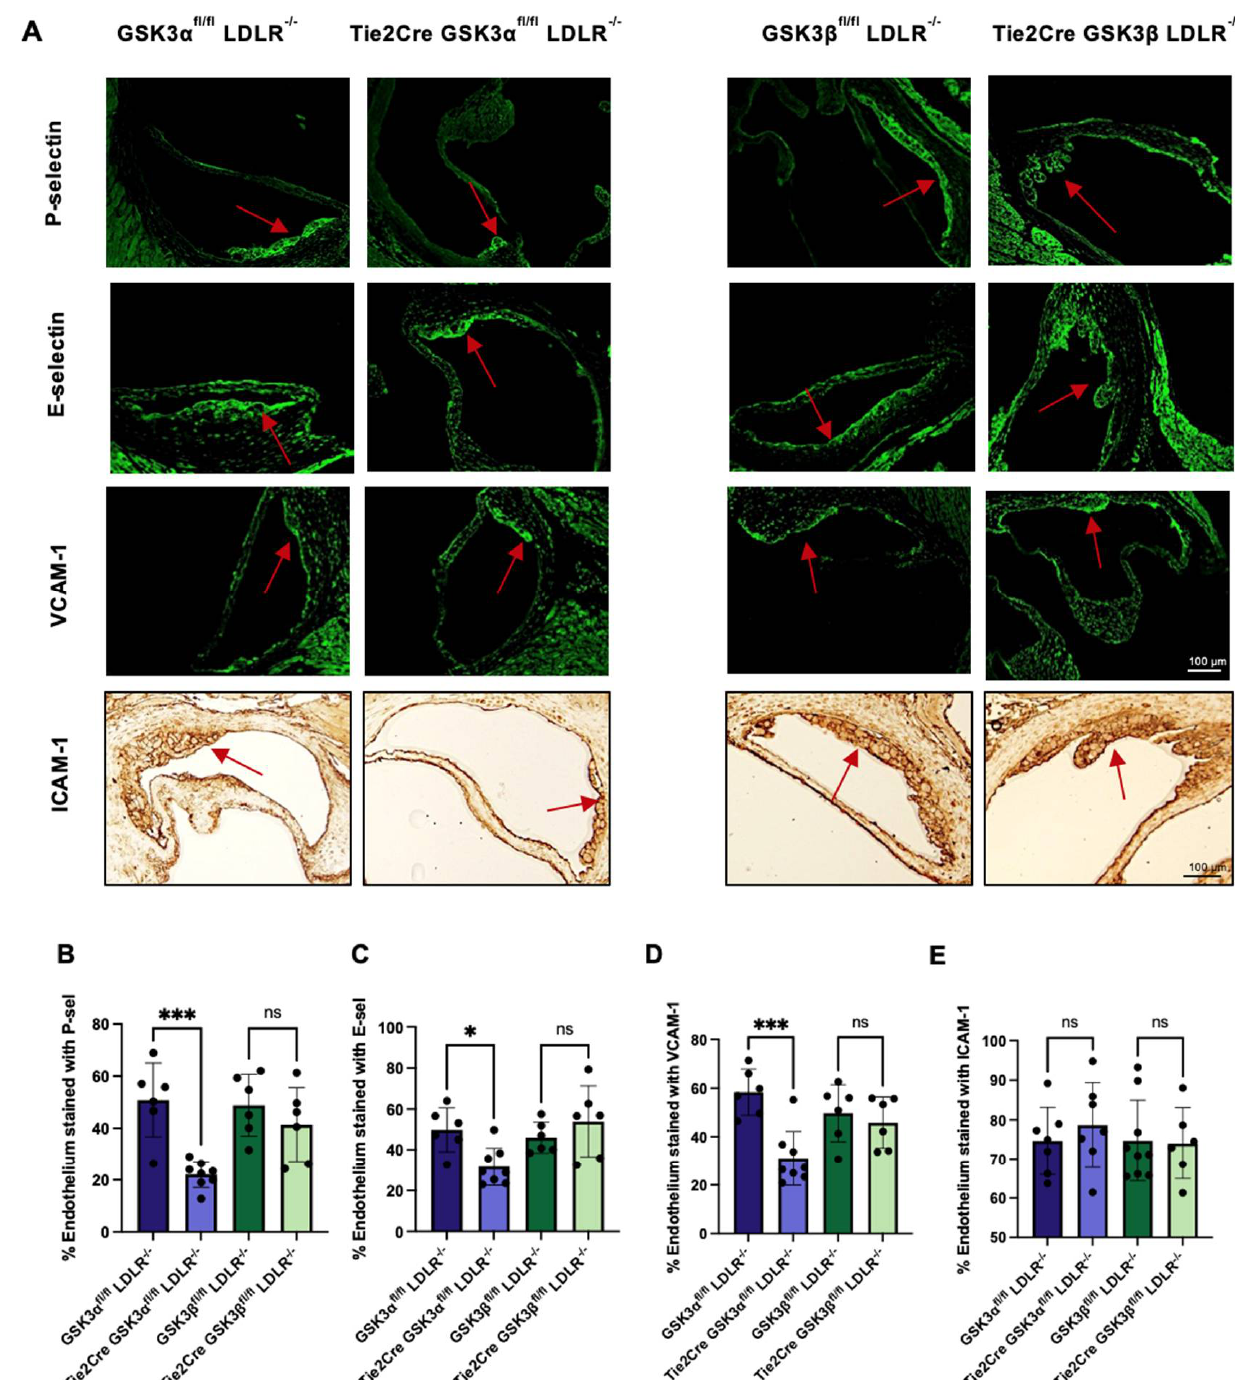
Figure 2. Adhesion protein expression in endothelial/macrophage GSK3 α / β knockout mice. ( A ) Representative images of stained aortic sinus cross sections from 15 week old endothelial/macrophage GSK3 α / β knockout and control mice. Red arrow indicates atherosclerotic plaque. Scale bar represents 100 µ m. Quantification of percentage of endothelium showing immunofluorescent staining of P-selectin ( B ) E-selectin ( C ) and VCAM-1 ( D ). EUR Quantification of immunohistochemistry staining of ICAM-1 expression on the endothelium. n = 6–8 ( B – E ), * p < 0.05, *** p < 0.0005. ns = not significant.